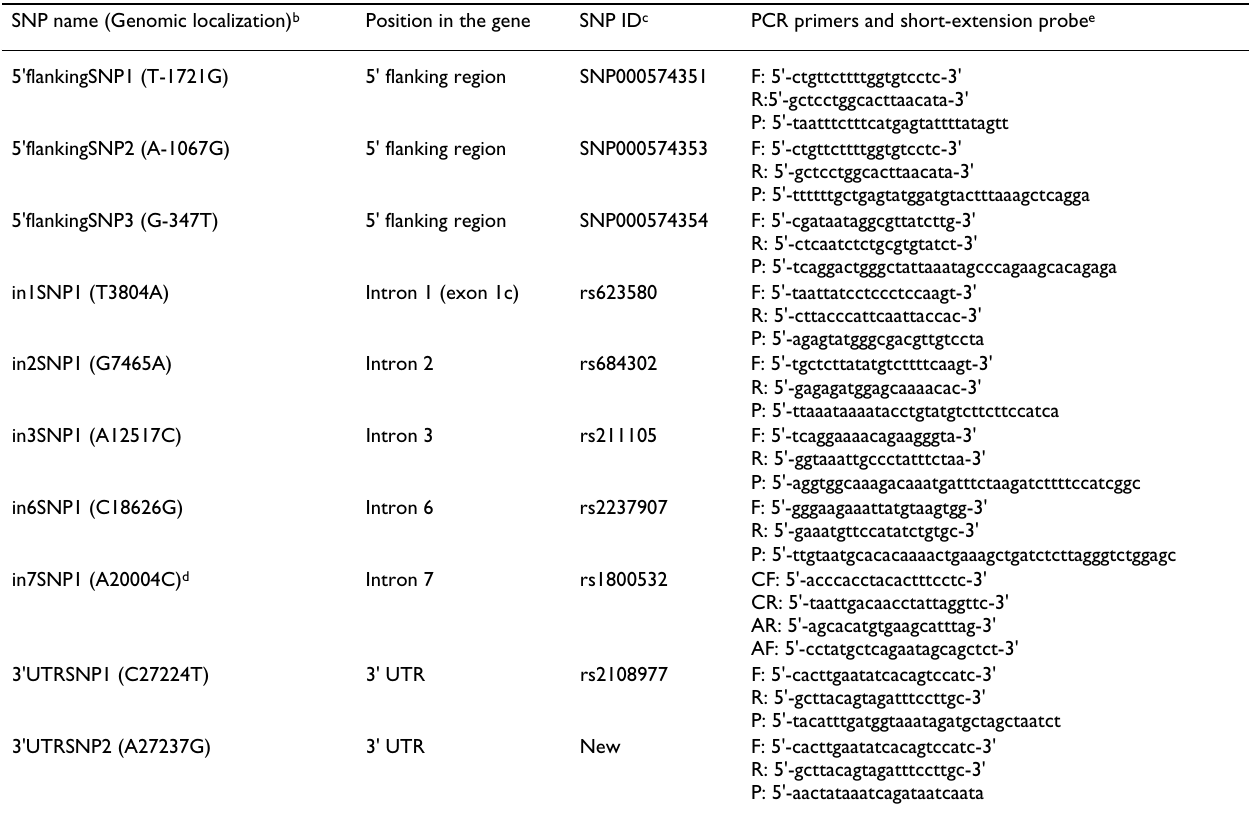
Table 1: Summary of the 10 human TPH1 SNPs genotyped in this study a SNP name (Genomic localization)